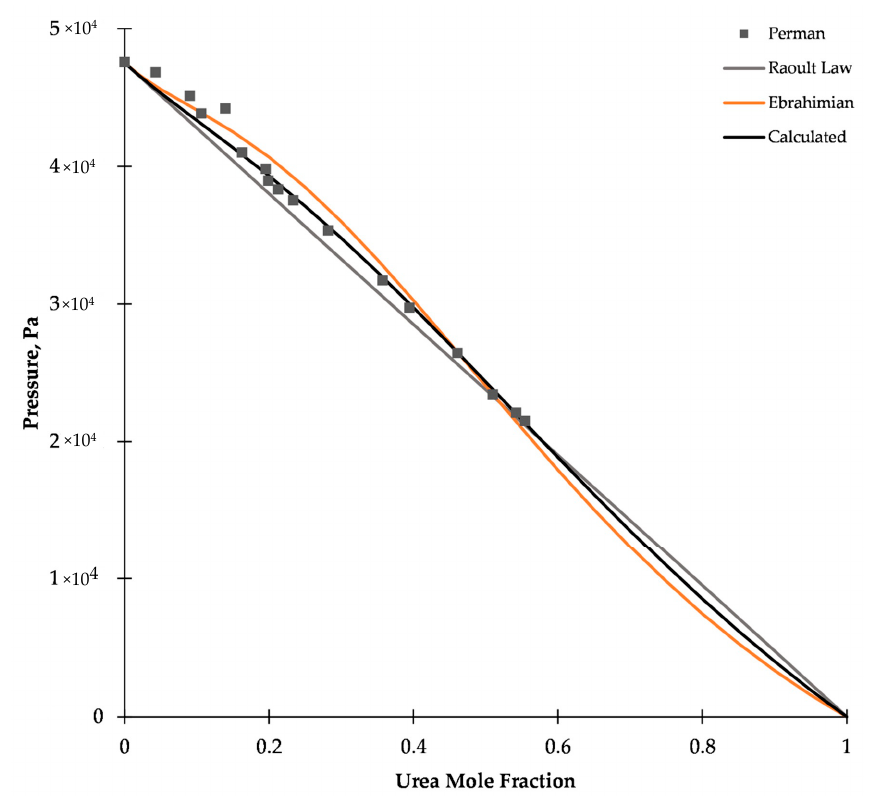
Figure 4. Vapor liquid equilibrium (VLE) results comparison.